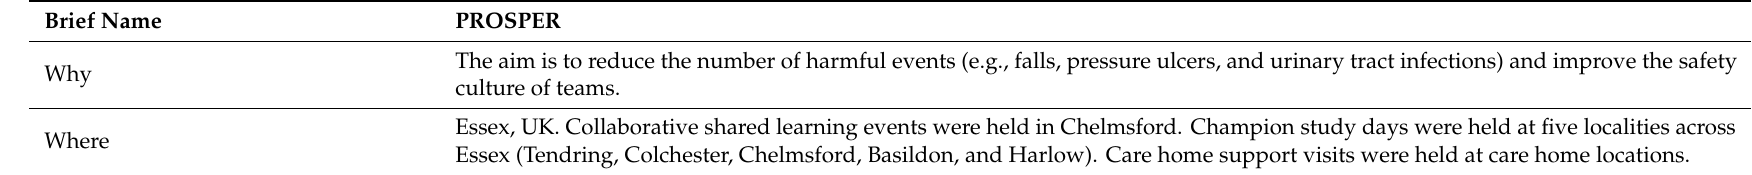
Table 3. Description of the PROSPER Quality Improvement